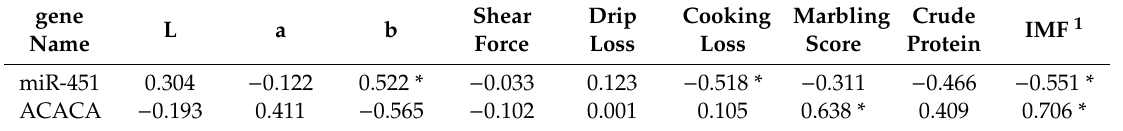
Table 2. Correlation analysis of ssc-miR-451 and ACACA expression with pork quality traits. gene